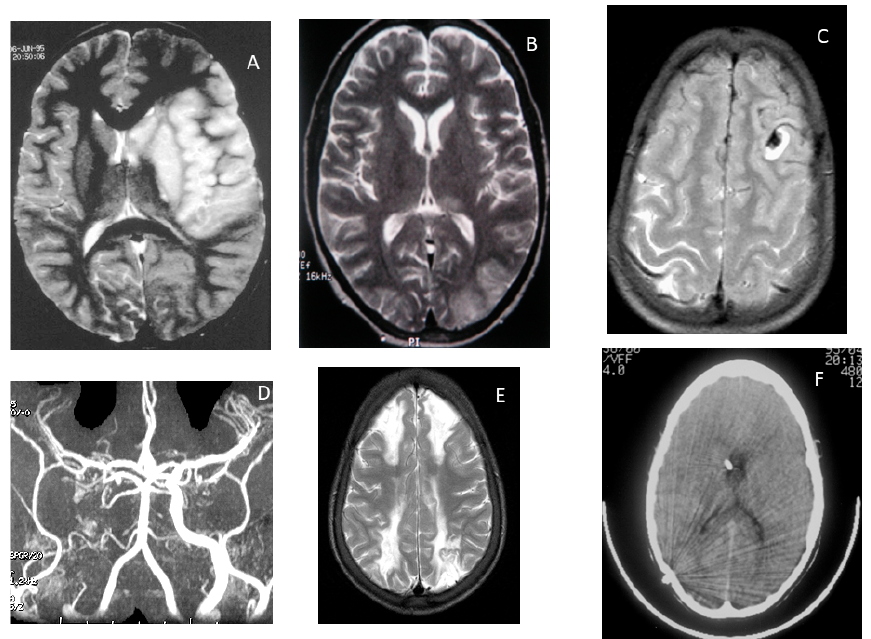
Figure 3. Stroke syndromes in sickle cell disease ( A ) arterial ischaemic stroke secondary to middle cerebral artery vasculopathy ( B ) posterior reversible encephalopathy syndrome ( C ) spontaneous intracerebral haemorrhage ( D ) extracranial carotid occlusion in a teenager with previous ataxia presenting with stroke ( E ) bilateral watershed infarction ( F ) straight sinus thrombosis.